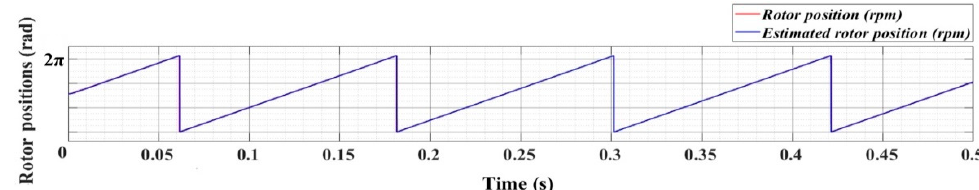
Figure 13. Time evolution of the rotor speed and of the estimated rotor speed of the PMSM.